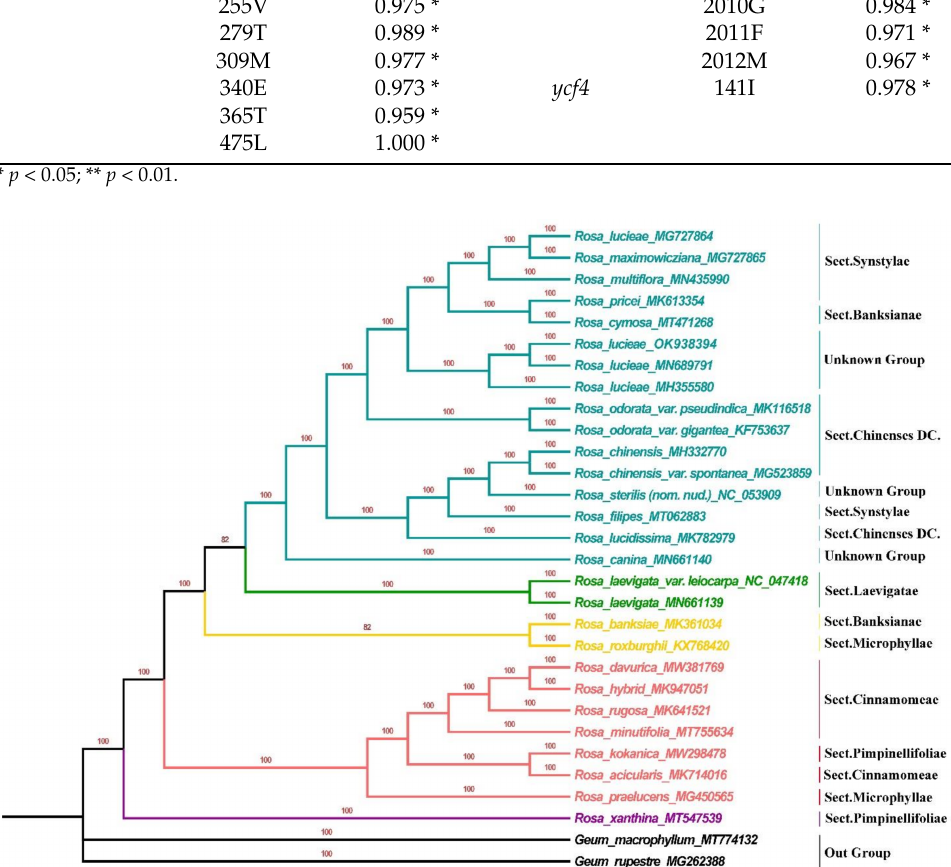
Figure 6. Molecular phylogenetic tree of Rosa based on 30 chloroplast genome